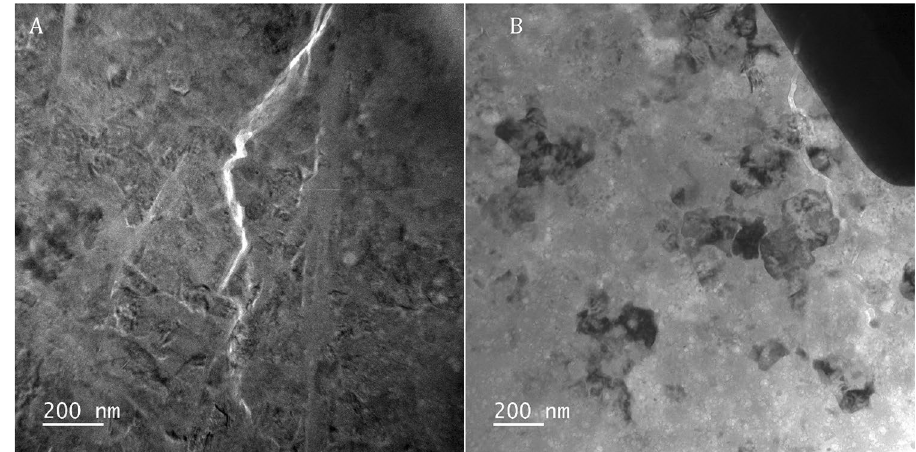
Figure 5. Bright-TEM images of Gr179. ( A ) TEM image of FIB prepared section showing that the samples consists of a highly-strained, dense aggregate of grossular grains with irregular shapes. The linear feature which runs N-S just to left of the center of the images appears to be a zone of shear, where significant grain size reduction has taken place, but the grossular in this zone has undergone beam damage due to electron beam irradiation; ( B ) Irregularly-shaped interlocking grossular grains in a region which appears to have undergone significant grain size reduction as indicated by a number of grains which are in strong diffracting orientations and have grains sizes < 150 nm. The grains also show significant diffraction contrast due to internal strain within the crystals. Significant regions of this area have undergone extensive electron beam induced amorphization, as indicated by the lack of diffraction contrast (all the medium gray regions). Amorphization has occurred heterogeneously within the sample, with islands consisting of crystalline grains occurring within the extensive regions of amorphized